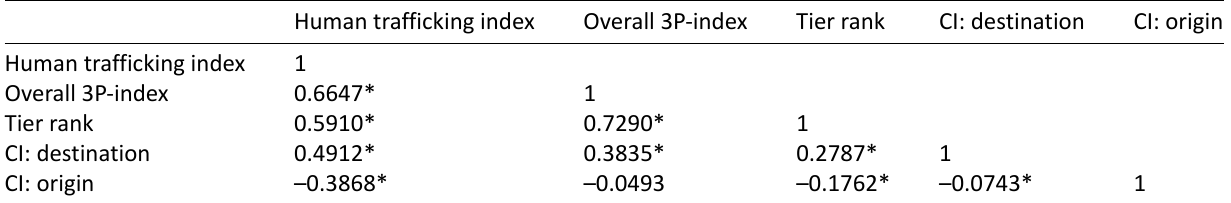
Table 3. Pairwise correlations of human trafficking